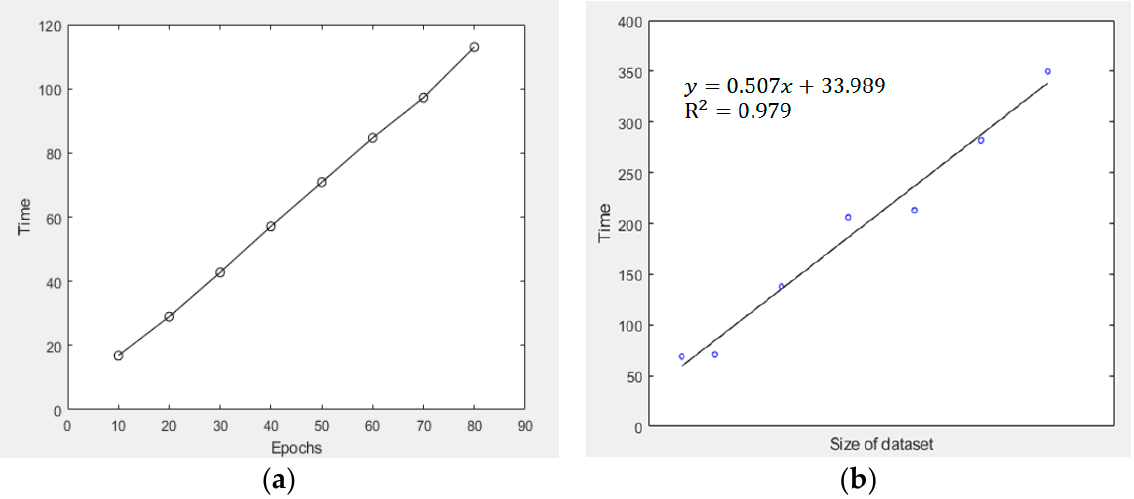
Figure 9. ( a ) Time consumed for VAE model training (in s) versus the number of epochs adopted in the model; ( b ) Time consumed for VAE model training (in s) versus the size of dataset ingested into the model.